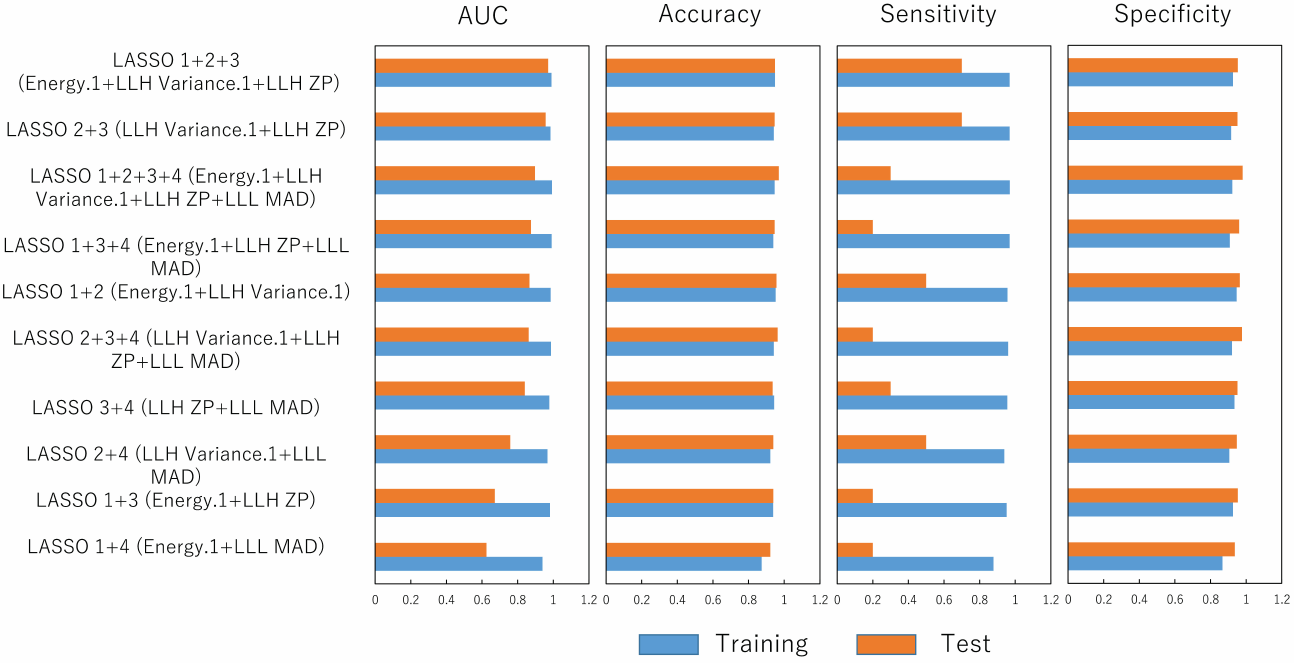
Figure 3. AUCs, accuracies, sensitivities, and specificities of 10 models with combinations of features selected by the top 1st–4th coefficients of